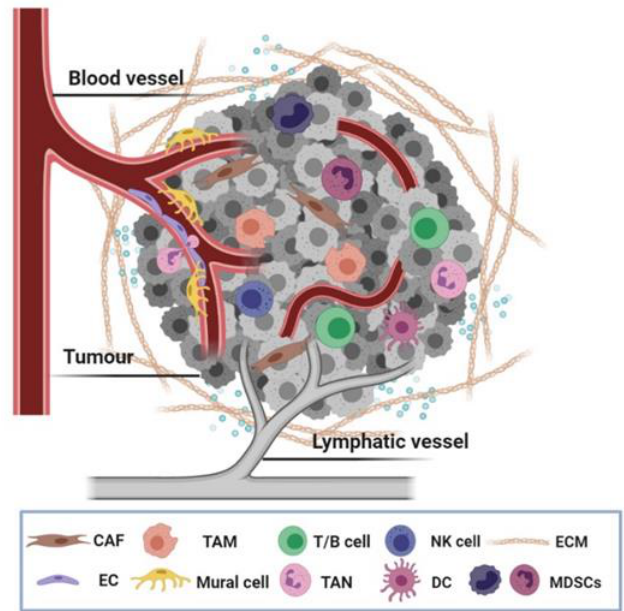
Figure 1. Tumour microenvironment (TME). Besides cancer cells (depicted in grey), distinct cell types and extracellular matrix (ECM) constitute the TME that controls cancer development and progression. Abbreviations: CAF, cancer-associated fibroblast; TAM, tumour-associated macrophages; MDSCs, myeloid-derived suppressor cells; NK cell, natural killer cell; EC, endothelial cell; DC, dendritic cell; TAN, tumour-associated neutrophils; ECM, extracellular matrix. As in normal tissue, all cells in the TME are attached and interact with ECM at specific